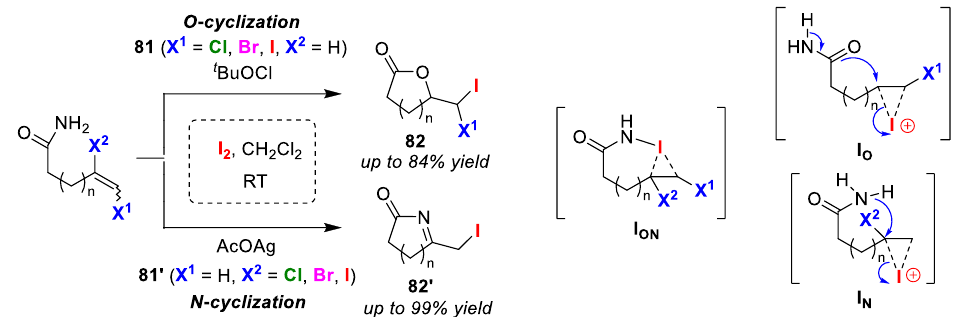
Figure 39. Intramolecular halogen substituent-dependent O/N atom-selective iodo-amino-cyclizations of the olefinic amides 81 and 8 1′ .